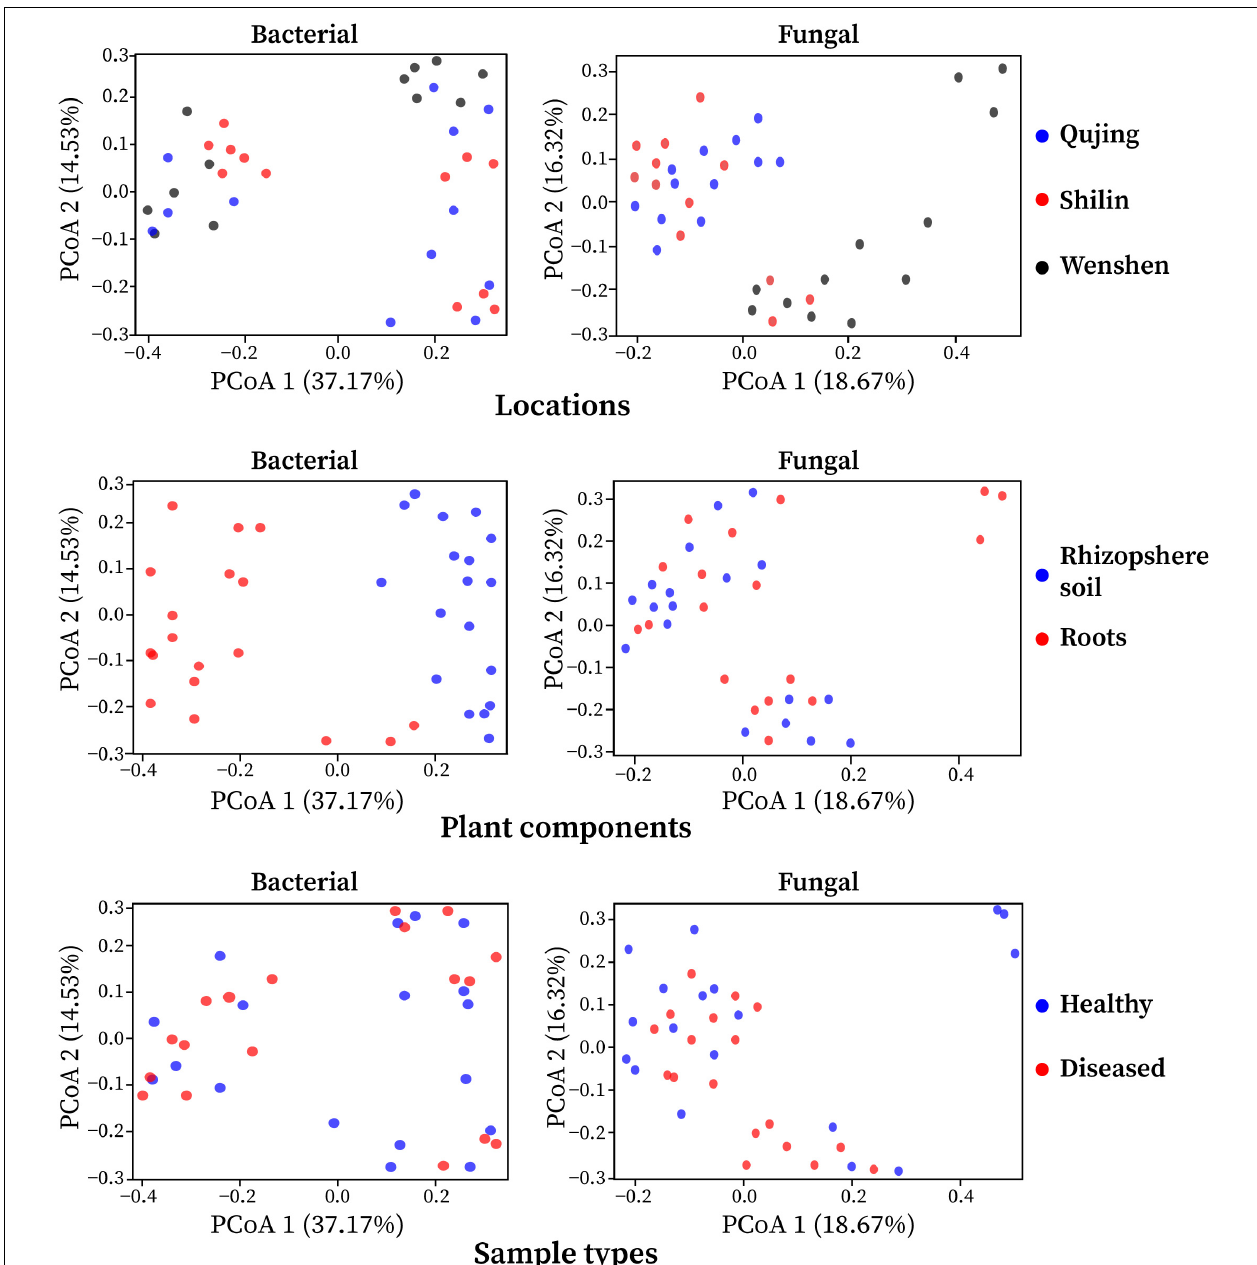
Bacterial and Fungal Community Composition at Phylum Level The top 10 bacterial and fungal phyla with relative abundance greater than 1% are shown in Figure 5 and Supplementary Table 3 . The dominant bacterial phyla in all rhizosphere soil and root samples with a relative abundance greater than 1% are